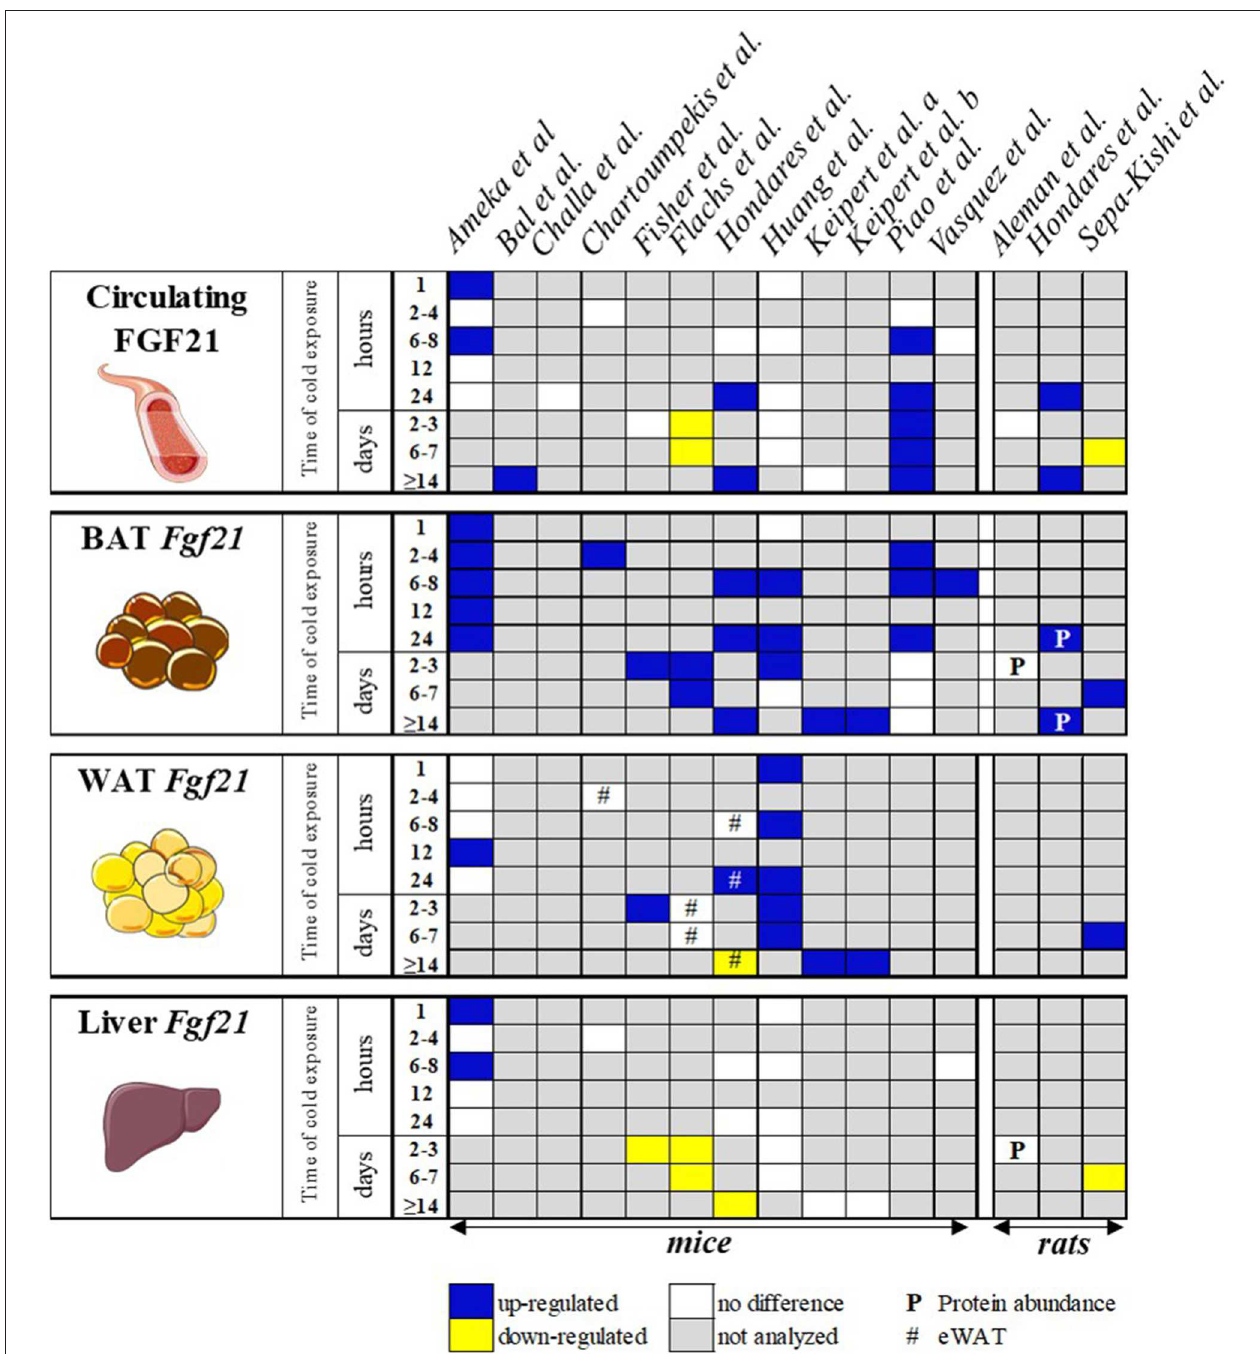
FIGURE 1 | Schematic overview of publications investigating the effect of cold exposure on circulating FGF21 and Fgf21 expression levels in various tissues of the WT control mice. Blue box, FGF21 was up-regulated; yellow box, FGF21 was down-regulated; white box, FGF21 not differently regulated vs . control; gray box, not analyzed. The data represent circulating levels and mRNA expression, unless otherwise specified. WAT, white adipose tissue (subcutaneous unless otherwise stated); BAT, brown adipose tissue. Keipert et al. a (13), b (14). Parts of this cartoon were created using Servier Medical Art (http://smart.servier.com).